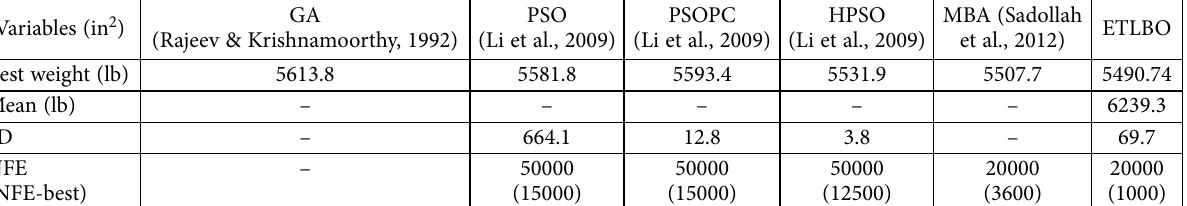
Table 3. Result of optimization algorithms 15-bar truss example